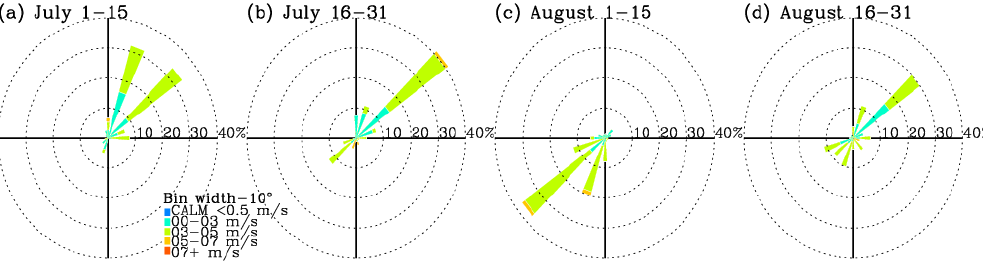
Figure 3. Wind roses for individual months from June through September in 2020 at Pohang. Note that hourly observations in daytime are used to be consistent with data processing done in Figs. 1 and 2.